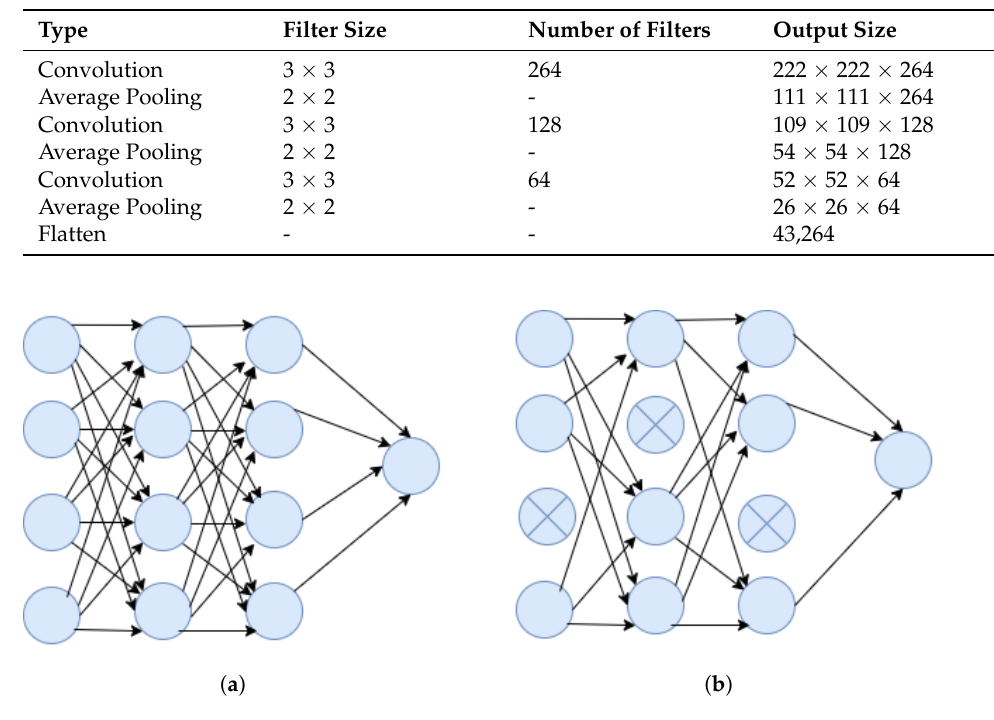
Figure 6. ( a ) Fully connected NN, ( b ) a network applying dropout.